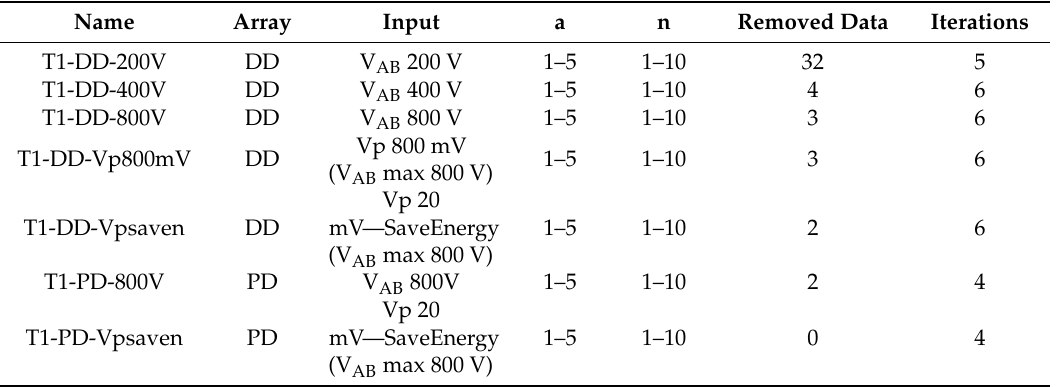
(dipole-dipole: DD and pole-dipole: PD) and di ff erent input